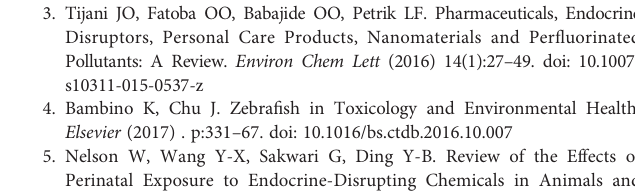
Supplementary Figure 3 | Thewhole-bodymRNAlevelsofbdnfandfosabrelated tostress,depression,andneurogenesisfollowingexposuretoFLX,BPA,VIN,andDEX. Thewhiteandblackbarsshowunstressedandstressedconditions,respectively.Panel (A) shows whole-bodymRNA levels for bdnf. From top to bottom graphs show bndf mRNA levelsin the FLX-O/N, FLX-6D, BPA, VIN, and DEX groups and their related controlgroup.Panel (B)